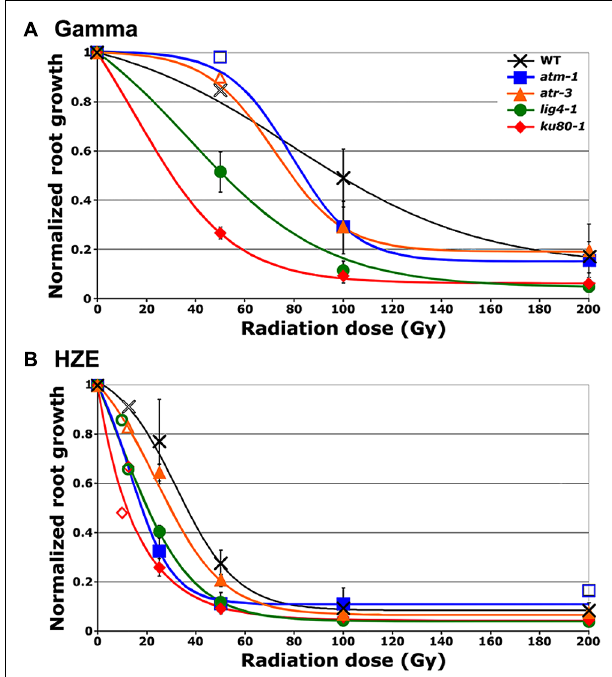
FIGURE 1 | Relative root growth of irradiated seeds 8 days after treatment. (A) Gamma treatment. (B) HZE treatment. Data points reflect results from three ( n = 3) biological replicates in the case of atm , and atr and four ( n = 4) biological replicates in the case of wild-type, lig4 and ku80 (Doses for which only a single biological replicate was performed are displayed as hollow data points.). Rootlengths from an average of 29 seedlings were scored per line, per treatment, per replicate. Lines represent interpolation of the data, fit to a sigmoid curve. Error bars depict standard error of the mean, as calculated and plotted by Microsoft Excel.